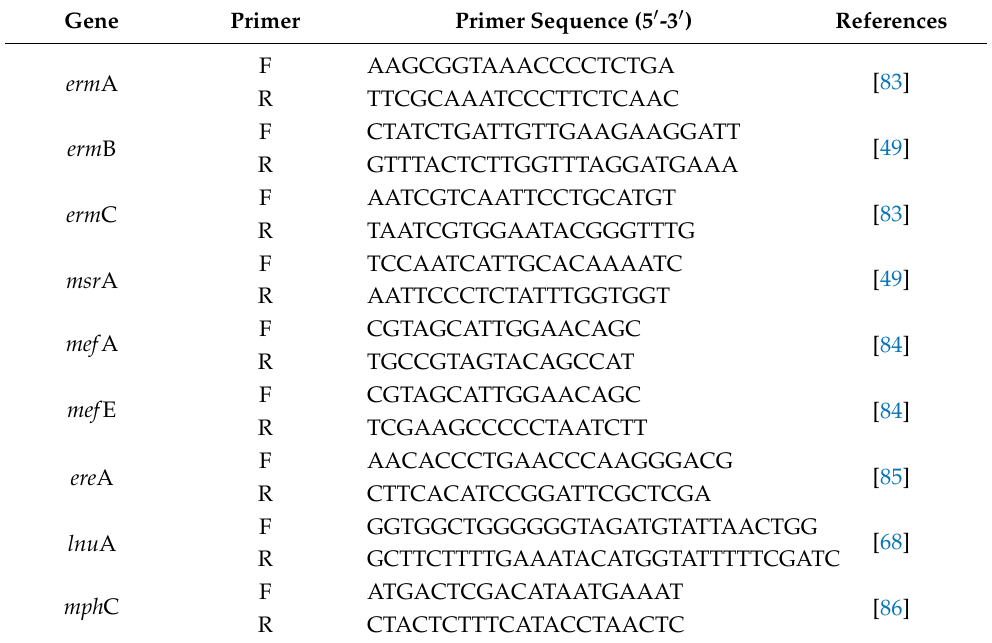
Table 3. Primers used in PCR for detection of resistance genes. Gene Primer Primer Sequence (5 (cid:48) -3 (cid:48)